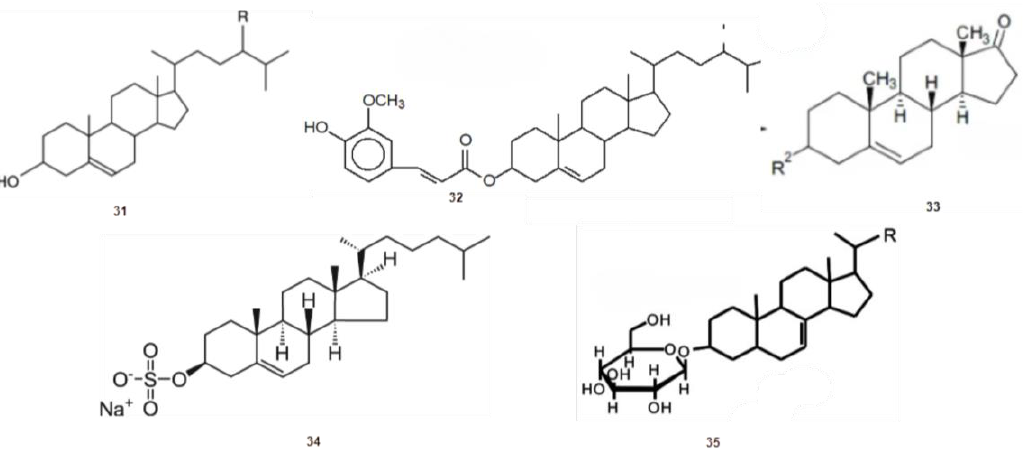
Figure 6. Sterols from macroalgae.